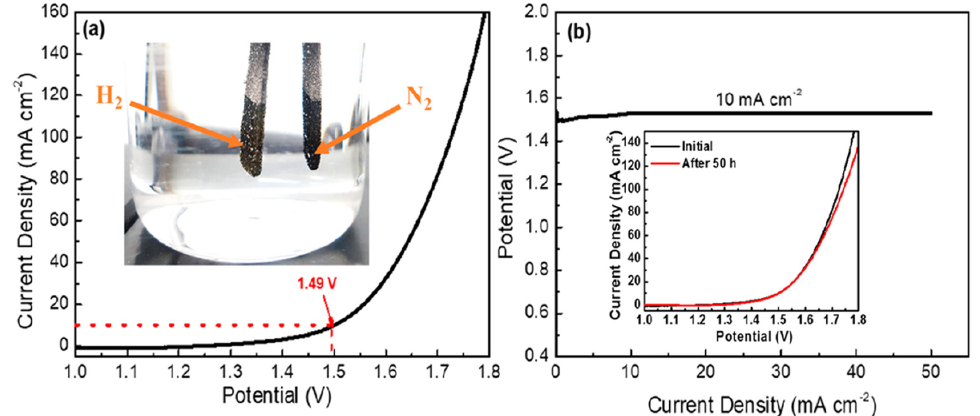
Figure 20. ( a ) Overall electrolysis in a two-electrode system in 1 M KOH with 0.33 M urea and ( b ) long-term stability over 50 h. The inset shows the polarization curves before and after the long-term stability test. Reprinted with permission from Ref. [92].